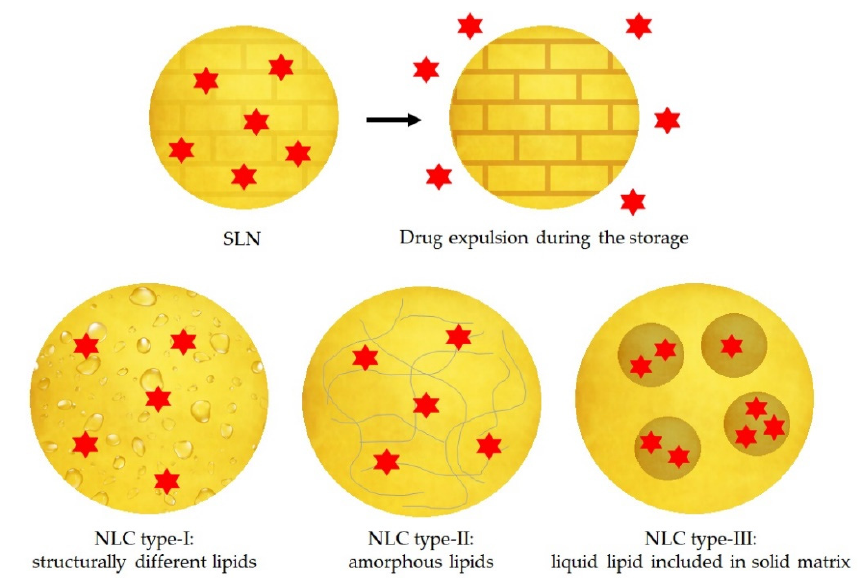
Figure 5. Representation of the drug expulsion during storage of SLNs and three types of NLC: type-I structurally different lipids, type-II amorphous lipids and type-III liquid lipid included in solid matrix. Red color indicates the active compound. Adapted from [68,69], Müller, R.H., 2002; Narvekar, M., 2014.